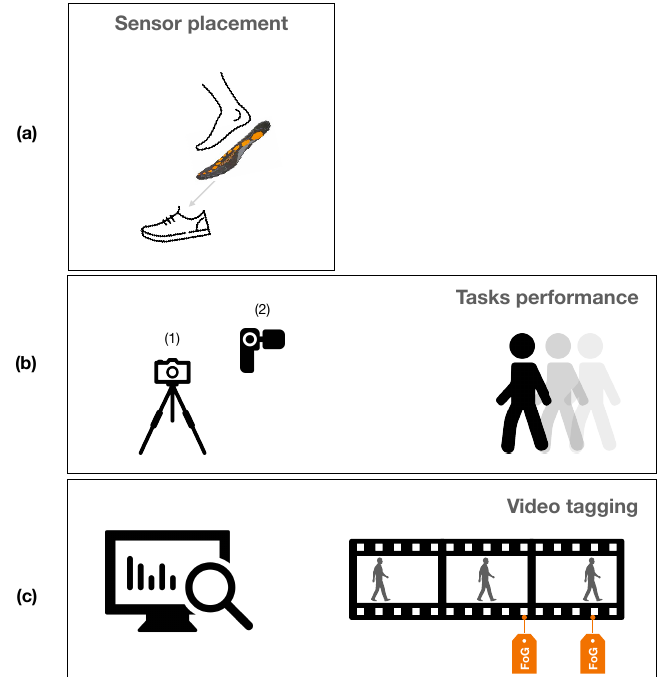
Figure 1. Data collection and processing protocol: ( a ) placement of the sensor insoles in the partici- pants’ shoes, then worn; ( b ) video recording of task performance (open a door, getting up from the bed, walking, etc.); ( c ) video tagging of Freezing of Gait (FoG) episodes (onset, duration, end). Table 2. List of motor tasks executed during each recording